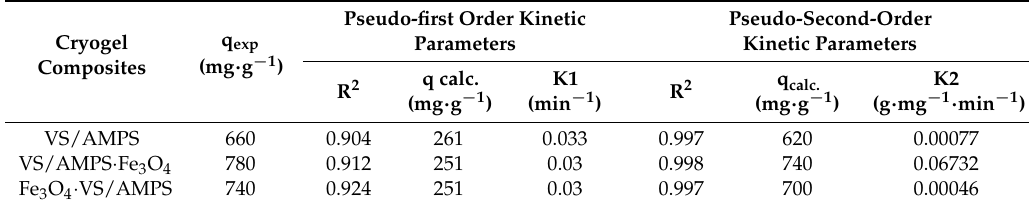
Table 4. Reuse Na-VS/Na-AMPS cryogel and its composites for removal of 1 m mol ∙ L −1 of MB aqueous solution at 298 K.